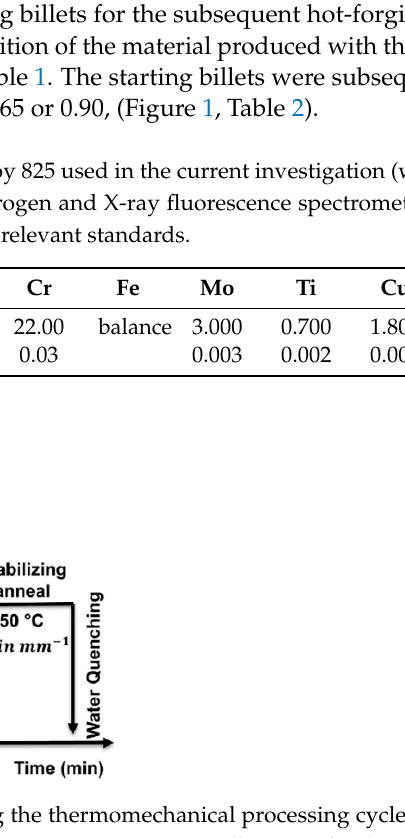
Table 1. Chemical composition of Alloy 825 used in the current investigation (wt. %). Combustion analysis was used for carbon and nitrogen and X-ray fluorescence spectrometry was used for all other elements in accordance with the relevant standards.